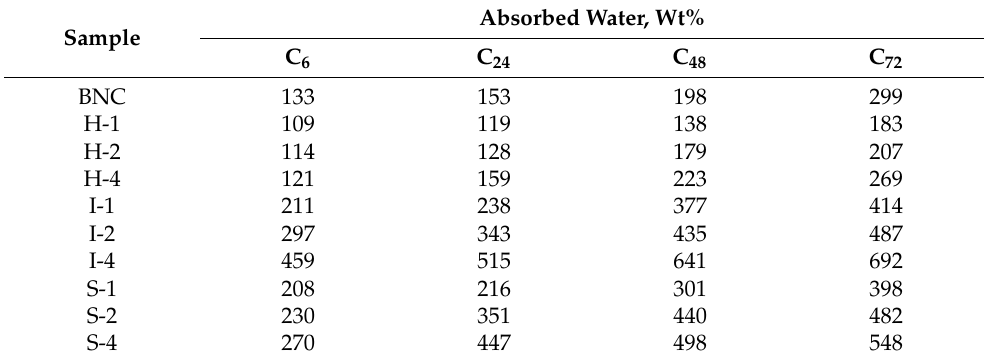
Table 6. Water absorption (wt.%) of BNC and BNC/PVA composites: C 6 , C 24 , C 48, and C 72 denotes the percentage of water in the sample after soaking for 6, 24, 48, and 72 h,